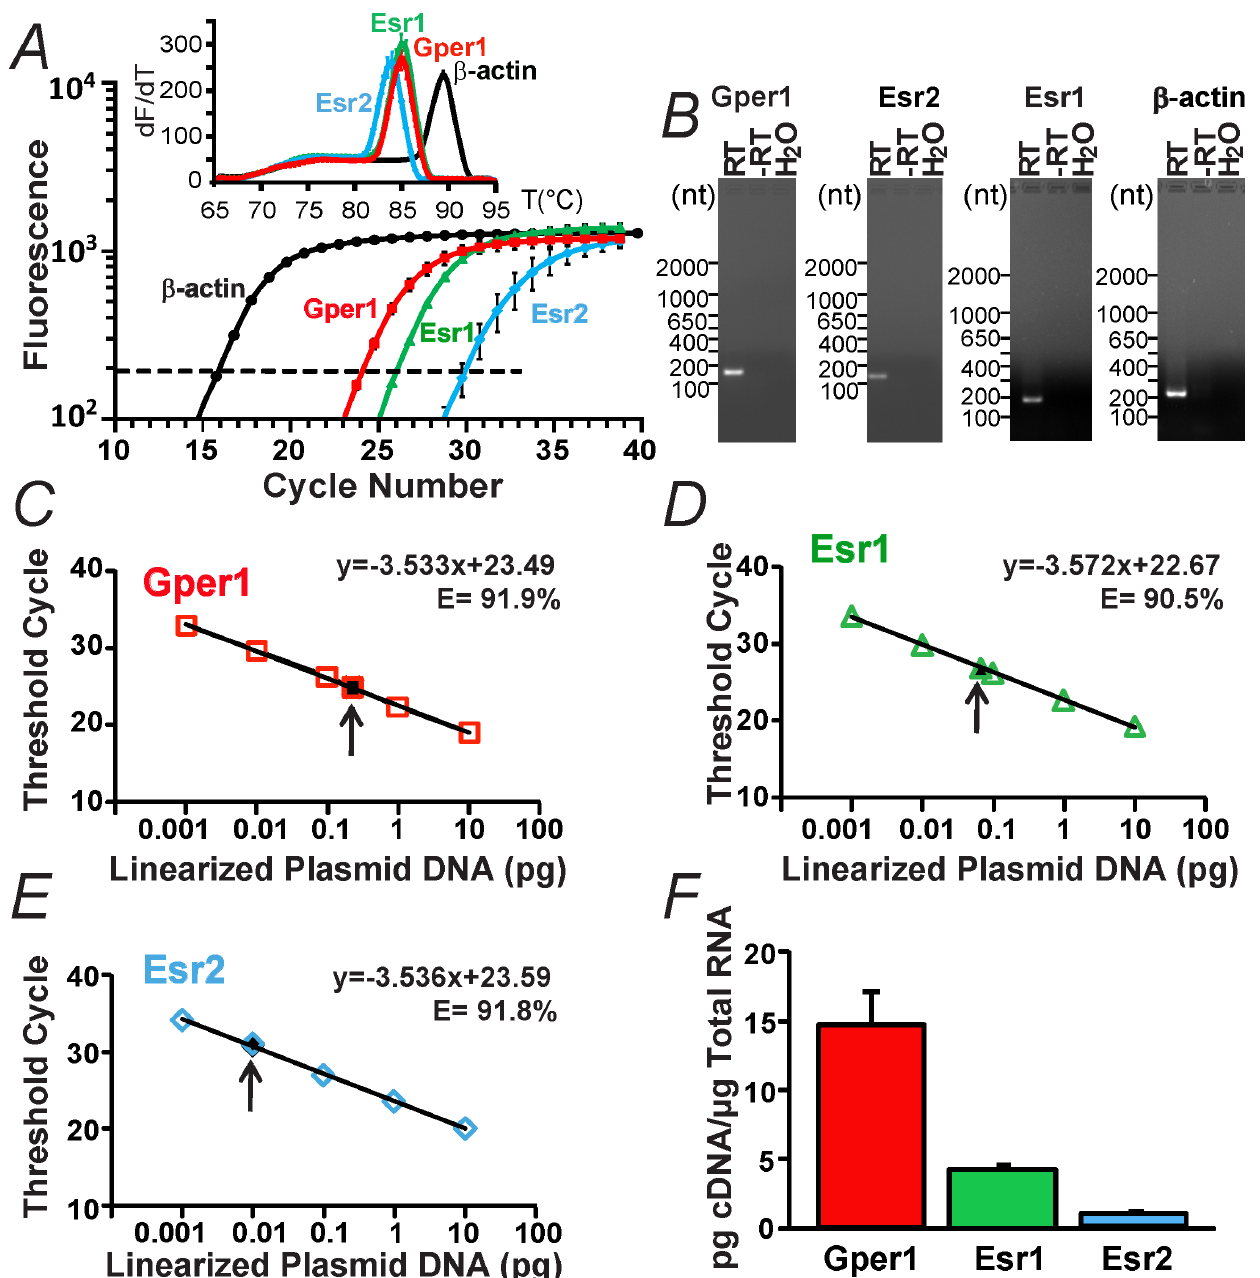
Fig 1. Gper1 transcripts predominate over Esr1 and Esr2 in male mouse heart. A. An example of relative fluorescence intensity versus PCR cycle number for Esr1, Esr2, Gper1 and β -actin (housekeeping gene) in mouse ventricle. Inset, melting curves for Gper1, Esr1, Esr2, and β -actin reactions. B. Real-time PCR end-products for Gper1, Esr1, Esr2 and β -actin with reverse transcriptase (RT), without RT (-RT) and water instead of total RNA (H 2 O). C-E. Standard calibration curves for Gper1, Esr1, and Esr2 DNA plasmids, respectively. Open symbols, known amount of linearized plasmid DNA. Closed symbols, interpolated absolute values of estrogen receptor cDNAs in mouse heart (arrow). F. Mean absolute values of Gper1, Esr1 and Esr2 transcript levels in mouse heart. Quantifications were performed in duplicate from samples of three different animals (n = 3). In this and following figures, data were acquired from male